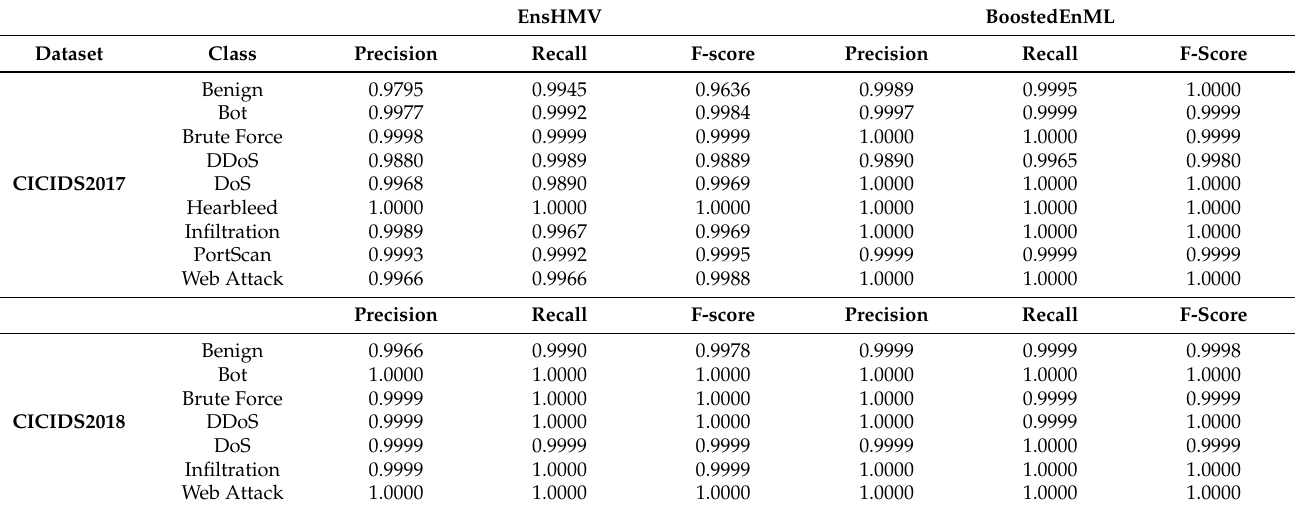
Figure 8. ROC curve for selected models trained on the CSE-CICIDS2018 dataset. Table 8. Performance of the IDS models (EnsHMV and BoostedEnsML) in detecting and classifying each network traffic class in the two